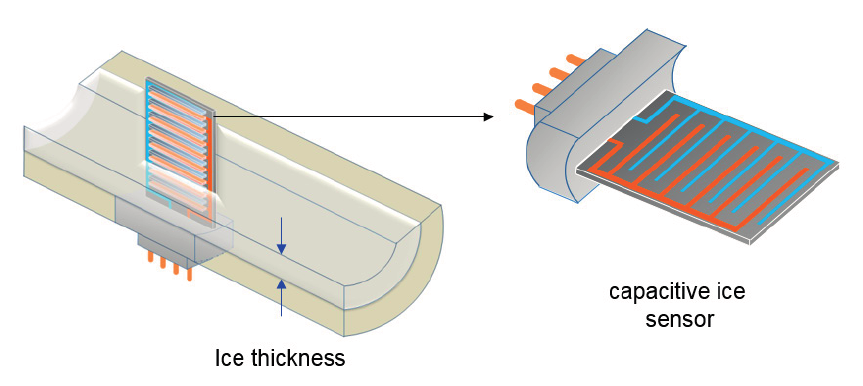
Figure 1. Schematic view of the capacitive ice sensor installed in a pipe to measure the ice growth from the inner surface of the fuel